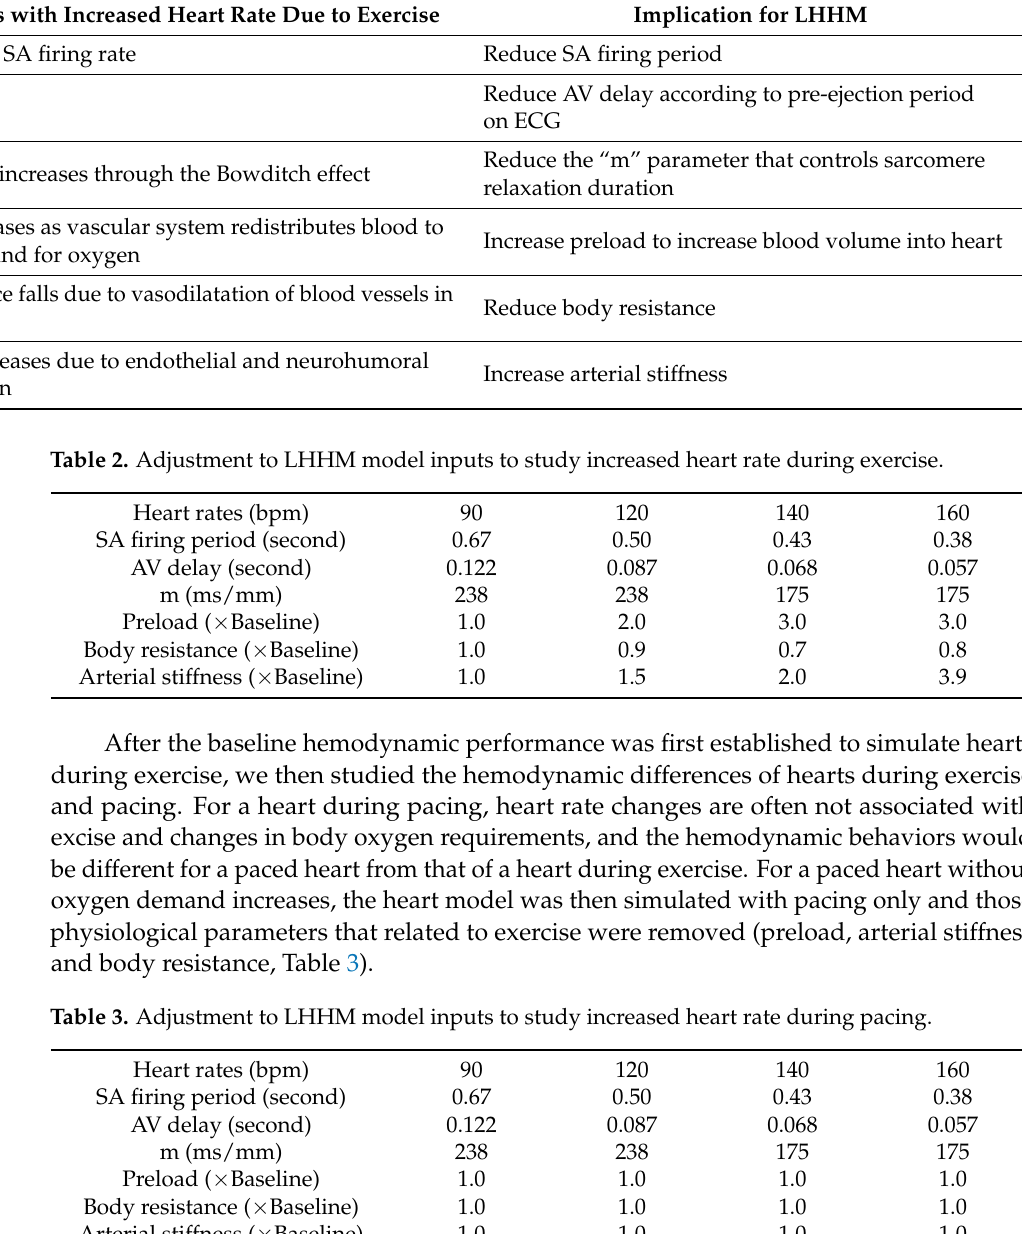
Table 1. Adjustments to LHHM model inputs to study increased heart rate during exercise.